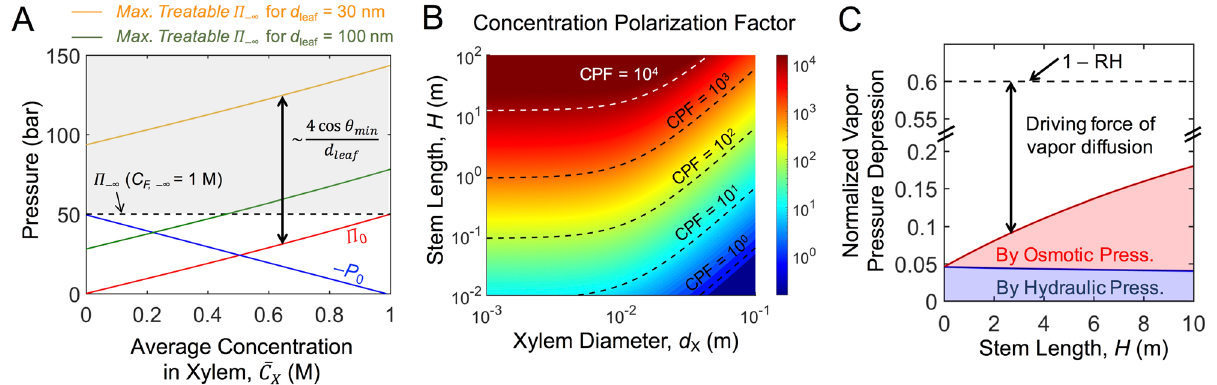
Figure 3. Effects of stem characteristics on water flow through artificial xylems. ( A ) Impact of solute concentration in the xylem on negative hydraulic pressure (− P 0 ) and osmotic pressure (Π 0 ) at the xylem-root membrane interface, and on maximum treatable osmotic pressures of feed (Π F,−∞ ) for two different leaf pore diameters ( d leaf ). Shown as a dotted line, feed solute concentration ( C F, −∞ ) of 1 M NaCl was used to calculate P 0 and Π 0 . The shaded area indicates a feasible range of treatable feed osmotic pressure, which is, ≈ � 0 + 4 γ cos θ min θ min is the receding contact angle in the leaf pore. For d C X > 0.47 M is leaf = 100 nm, d leaf , where required to recover water from the feed of 1 M NaCl. ( B ) Degree of concentration polarization in the xylem conduit determined by stem length ( H ) and xylem conduit diameter ( d X ). Concentration polarization factor (CPF) is defined as CPF ≡ ( C X,H − C X,0 )/ C X . ( C ) Vapor pressure depressions on the leaf pore, due to the negative hydraulic pressure (blue shaded area) and the elevated osmotic pressure (red shaded area) by the concentration polarization in the xylem. The vapor pressure depressions are normalized to P sat 0 ( T ). The dotted line indicates 1 − RH , and the gap between the dotted line and the shaded areas represents the driving force for water vapor diffusion from the leaf surface to the ambient. Here, d X = 0.01 m is considered for the maximized concentration polarization, as shown in ( B ). For all calculations in ( B ) and ( C ), C F, −∞ = 1 M NaCl and C X = 0.5 mM are considered. A R is set as 100 to induce severe concentration